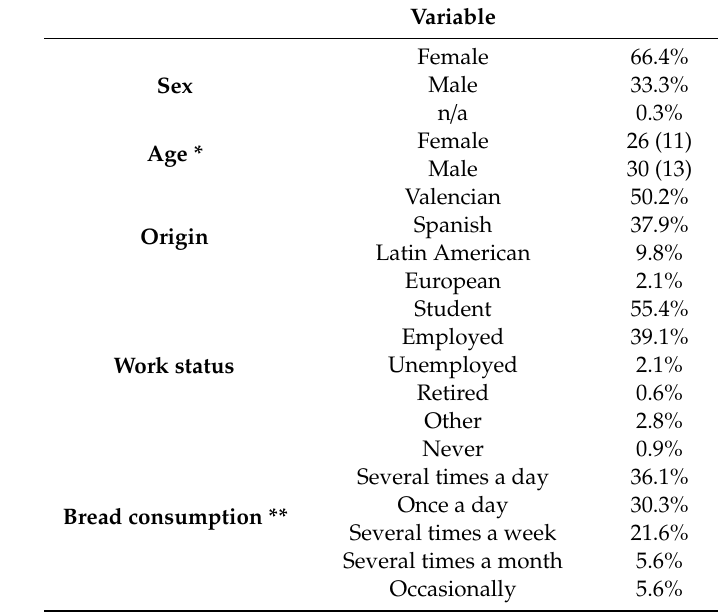
Table 4. Characteristics of the respondent at word association